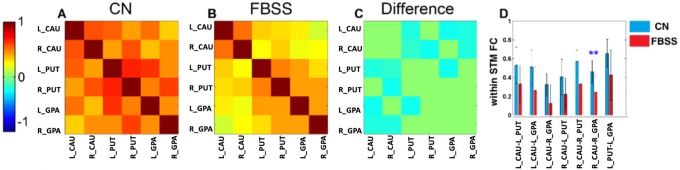
Regional FC within STM network for CN (A), FBSS (B) and the difference (C).The values of FC between left caudate and left putamen, left caudate and left globus pallidus, left caudate and right globus pallidus, right caudate and left putamen, right caudate and right putamen, right caudate and right globus pallidus, left putamen and left globus pallidus significantly decreased in FBSS group compared to CN. After using the Bonferroni method, the only significant decrease in FC between CN and FBSS groups within STM was between right caudate-right globus pallidus (** indicates p<0.05). Legend: Left and right caudate (L_CAU and R_CAU), left and right putamen (L_PUT and R_PUT), left and right globus pallidus (L_GPA and R_GPA).